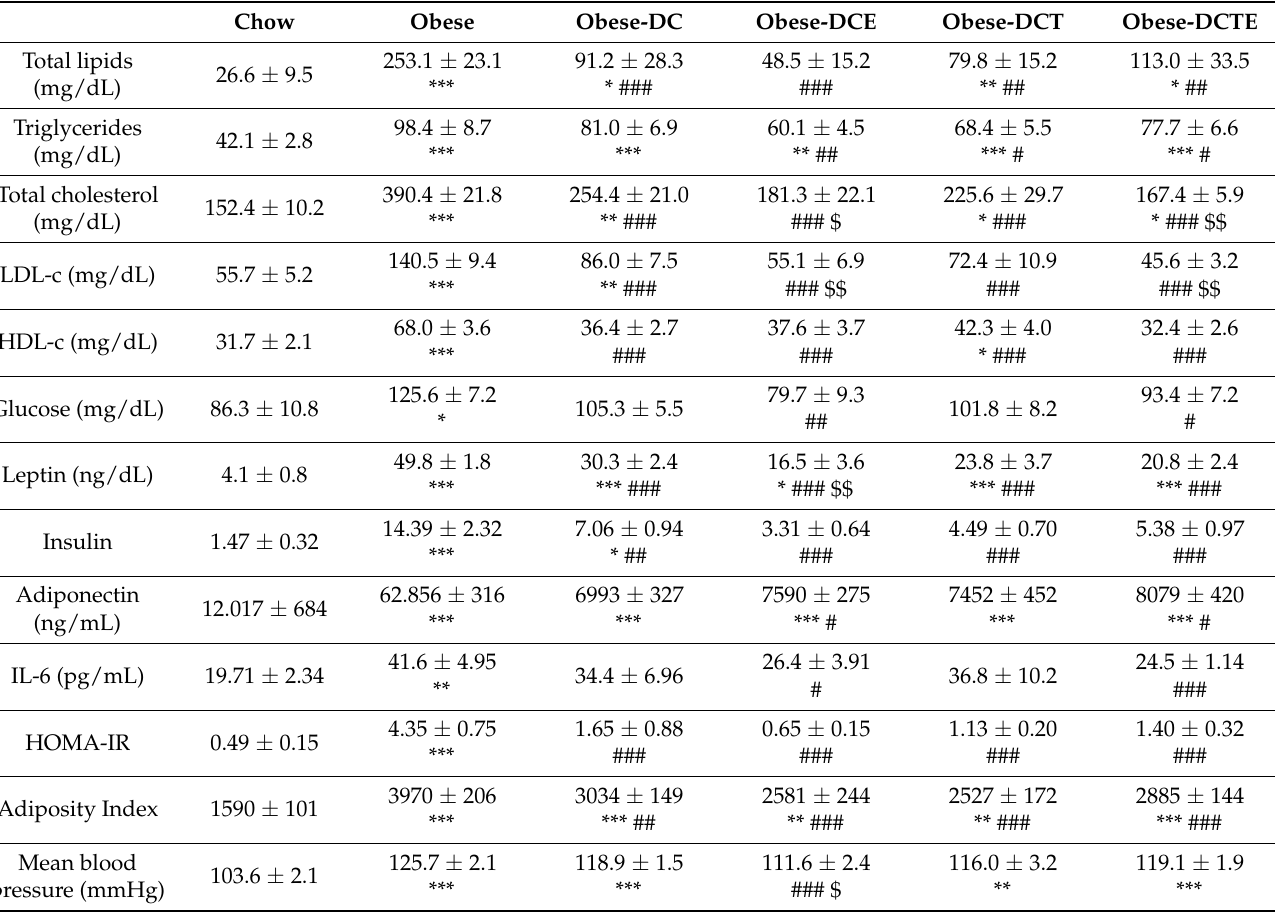
Table 2. Plasma levels of total lipids, triglycerides, total cholesterol, low-density lipoproteins (LDL)- cholesterol, high-density lipoproteins (HDL)-cholesterol, glucose, leptin, insulin, adiponectin, and interleukin-6 (IL-6) and mean blood pressure. Chow = mice fed a standard diet for 25 weeks; Obese = mice fed a high fat (60% kcal from fat)/high sucrose diet for 25 weeks; DC = mice fed a high fat (60% kcal from fat)/high sucrose diet for 23 weeks and switched to a diet with lower caloric intake (25% kcal from fat) for two weeks; DCE = mice fed a high fat (60% kcal from fat)/high sucrose diet for 23 weeks and switched to a diet with lower caloric intake (25% kcal from fat) supplemented with CSAT+ ® for two weeks; DCT = mice fed a high fat (60% kcal from fat)/high sucrose diet for 23 weeks and switched to a diet with lower caloric intake (25% kcal from fat) and subjected to aerobic training for two weeks; DCTE = mice fed a high fat (60% kcal from fat)/high sucrose diet for 23 weeks and switched to a diet with lower caloric intake (25% kcal from fat) supplemented with CSAT+ ® and subjected to aerobic training for two weeks; HOMA-IR = Homeostatic Model Assessment for Insulin Resistance index. Values are represented as mean ± SEM; n = 8–10 mice/group. * p < 0.05 vs. chow; ** p < 0.01 vs. chow; *** p < 0.001 vs. chow; # p < 0.05 vs. obese; ## p < 0.01 vs. Obese; ### p < 0.001